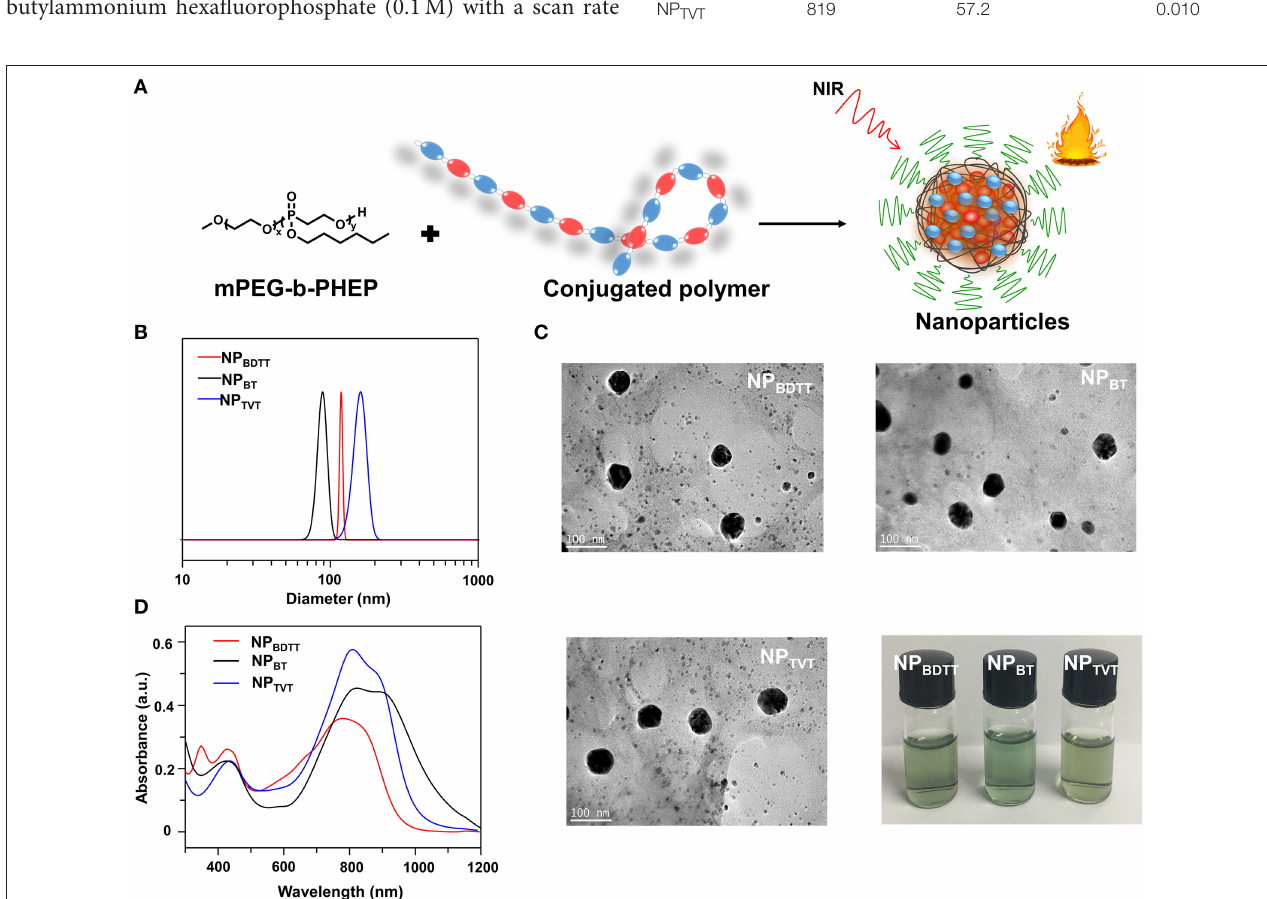
FIGURE 3 | (A) Scheme illustration of the nanoparticles prepared. (B) Size distributions. (C) TEM images and Photographic images. (D) Absorption spectra of NPs (10.0 µ g/mL).